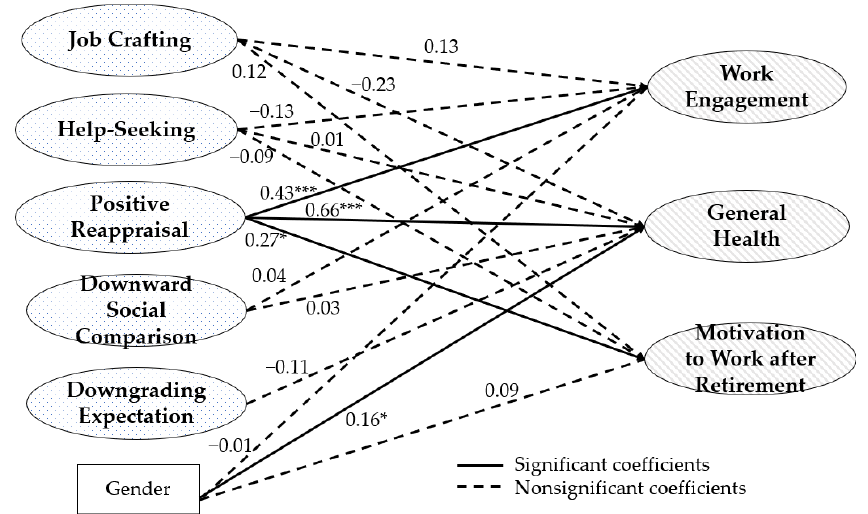
Figure 1. SEM path analysis results for middle-aged group. * p < 0.05; *** p < 0.001.